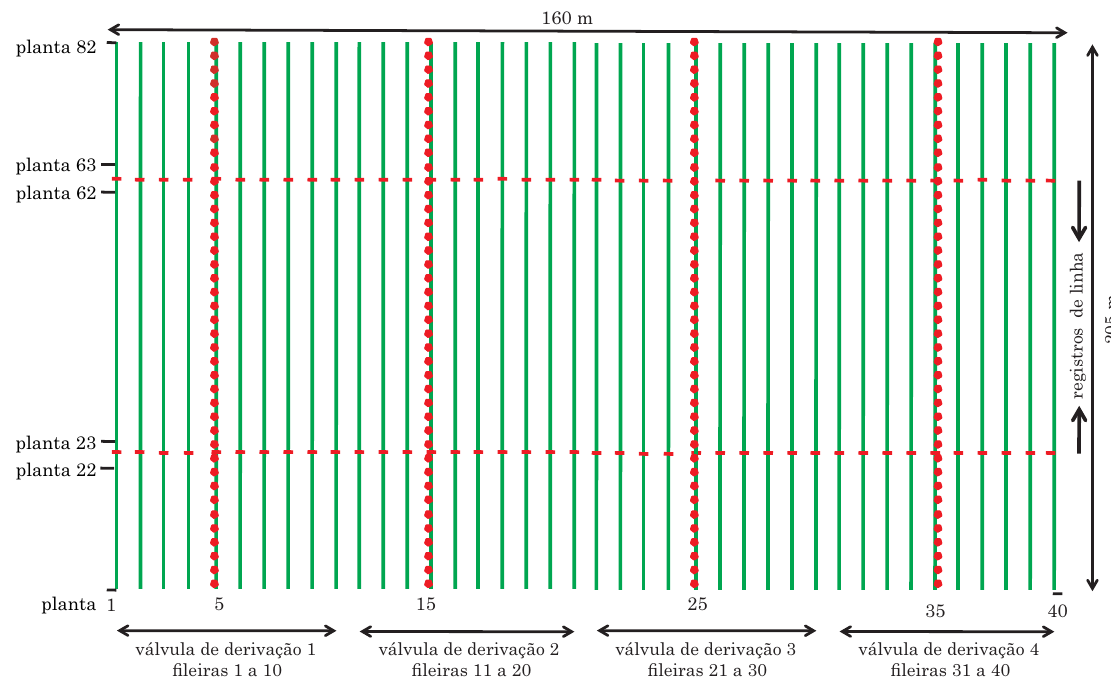
Figura 1. Croqui com as transeções (fileiras 5, 15, 25 e 35) para coleta de solo nas camadas de 0-0,2 e 0,2-0,4